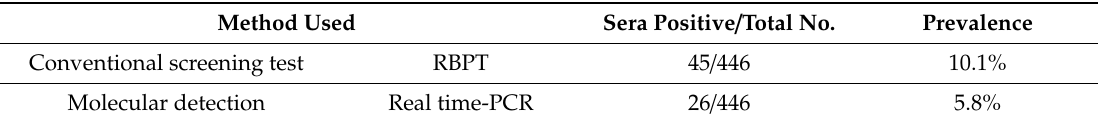
Table 2. Comparison of the results of di ff erent serological and molecular methods used to investigate the prevalence of human brucellosis in the Rawalpindi / Islamabad region,